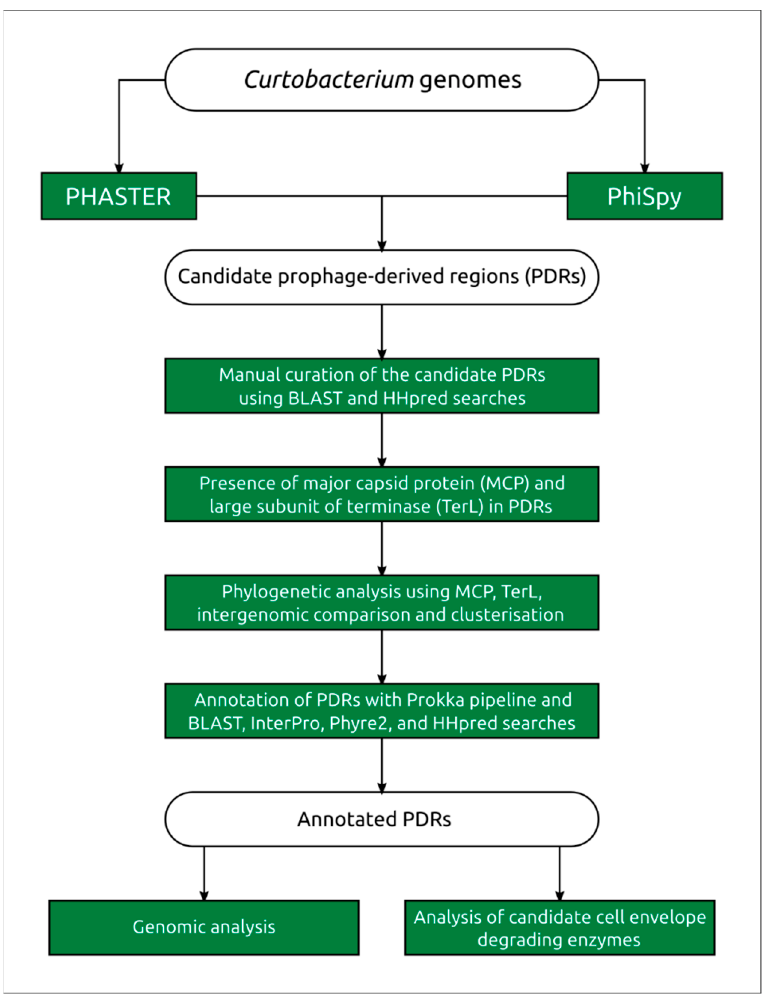
Figure 2. Flow chart of the identification and characterisation of Curtobacterium prophage-derived regions. The rectangles represent the tools and methods used for identification of PDRs; the rounded rectangles represent the data used for the analyses.